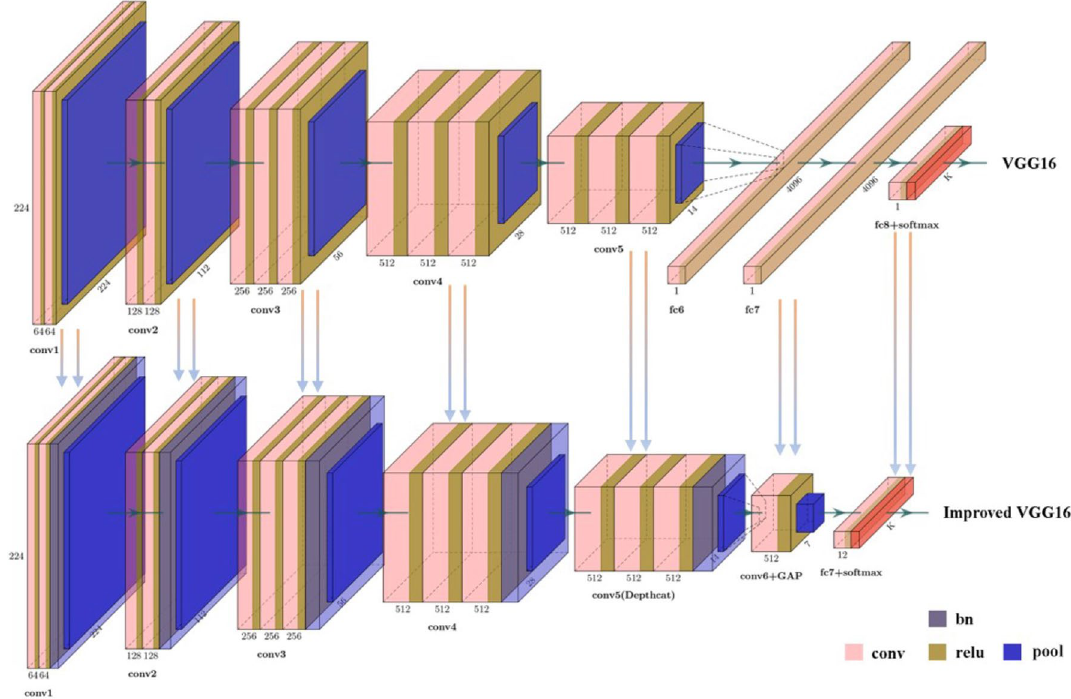
Figure 4. Network structure diagram of VGG16 and Improved